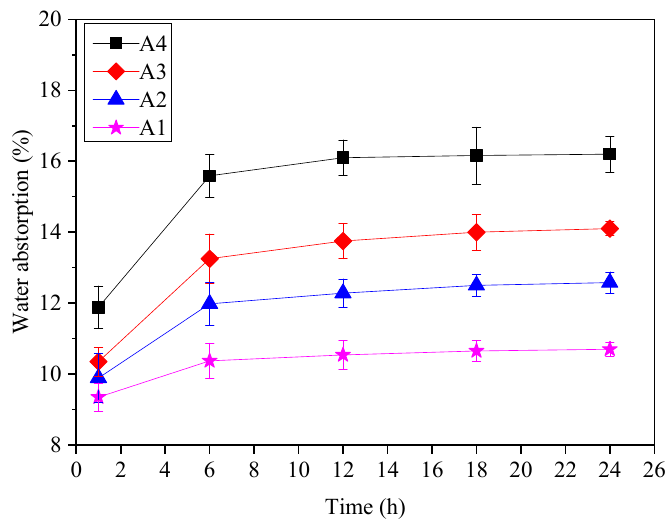
Figure 10. Water absorption of RM-based SFLAs.